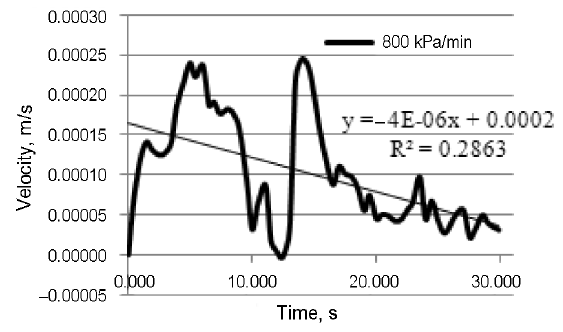
Fig. 6. Controlled vertical stress ramp (800.0 kPa/min) versus time